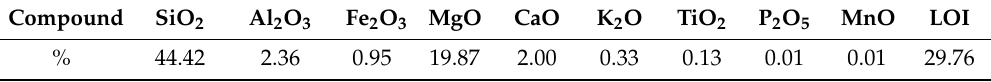
Table 1. Chemical composition of